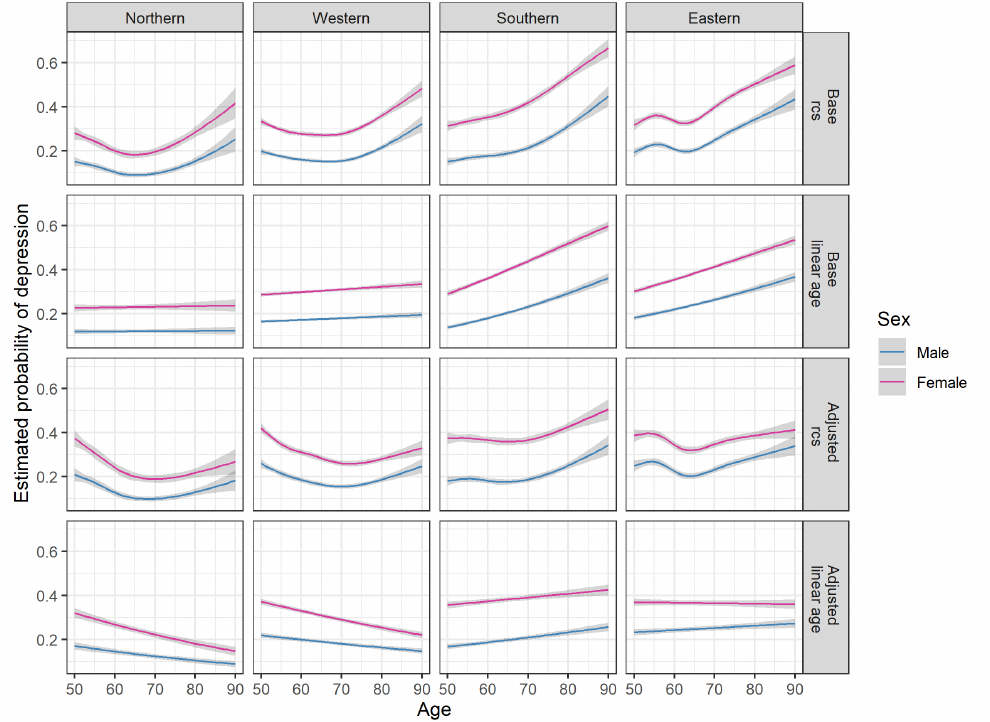
Figure A2. Comparison of the estimated probabilities modeling age with restricted cubic splines (rcs) or linearly. Estimates were obtained using logistic regression models including two-way interactions between age, sex and region (base model) and additional risk factors (education, BMI, current smoking, presence of chronic disease, vigorous physical activity, living arrangement; adjusted model); age was modelled using restricted cubic splines (rcs) or linearly (linear age). See Table 1 for sample sizes within each region and by sex, and for descriptive